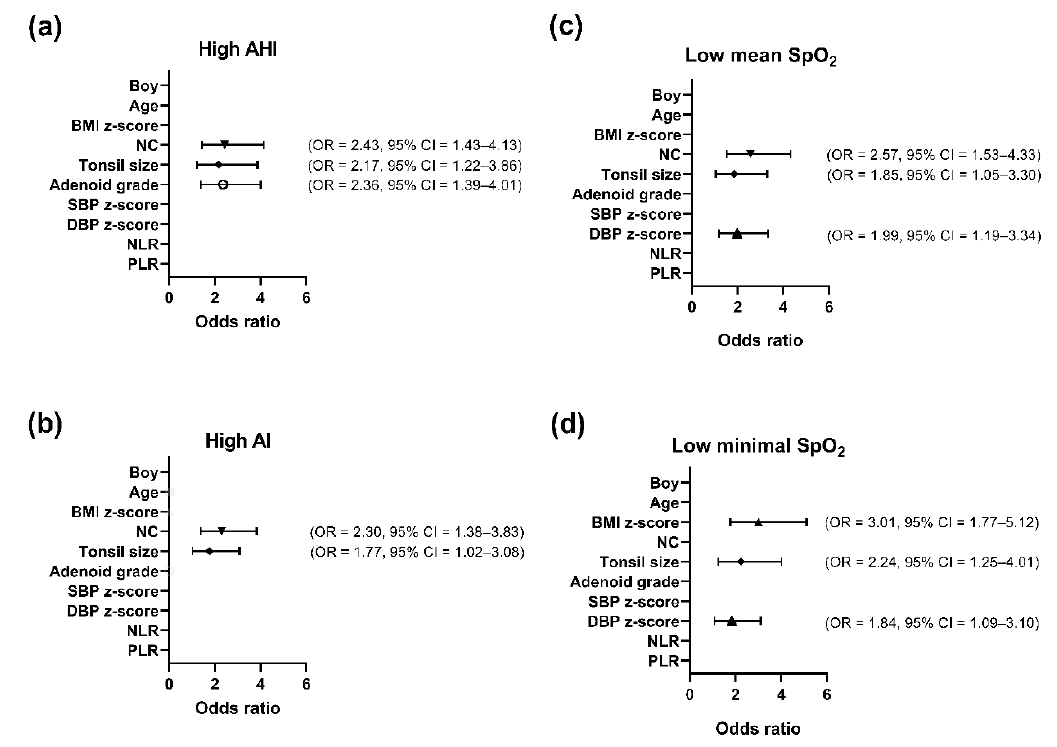
Figure 1. Variables independently associated with AHI, AI, mean SpO2, and minimal SpO2 in the overall cohort. ( a ) High NC, tonsil size, and adenoid grade were independently associated with high AHI.; ( b ) high NC and tonsil size were independently associated with high AI.; ( c )